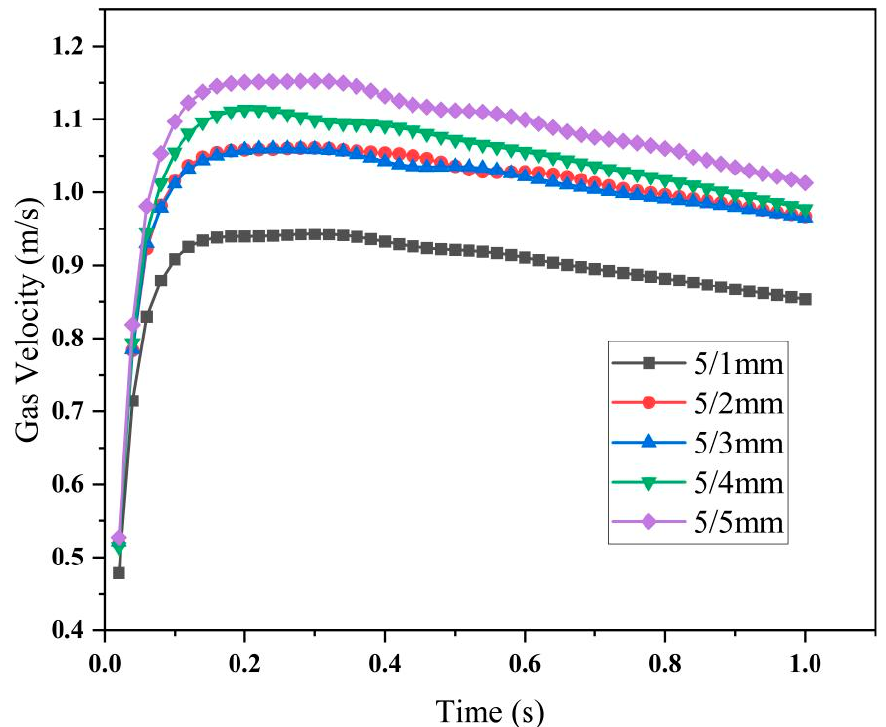
Figure 14. Velocity of a point in a fracture with different fracture widths.